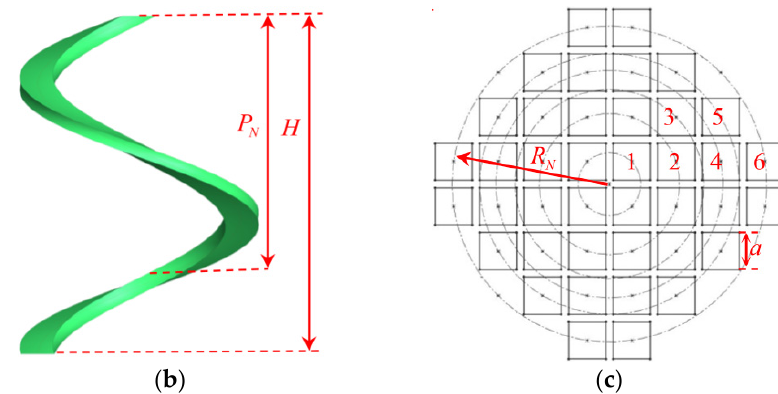
Figure 1. Schematic diagram of the MSC-AM structure. ( a ) 3D model of the structure; ( b ) 3D model of a single spiral chamber; ( c ) 2D sketch of the structure section.